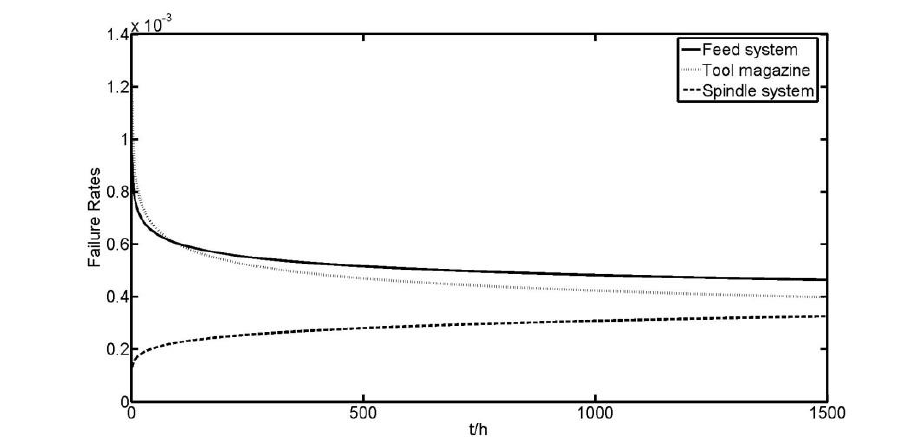
Figure 3. Failure rates 𝜆(𝑡) curve of key subsystems.